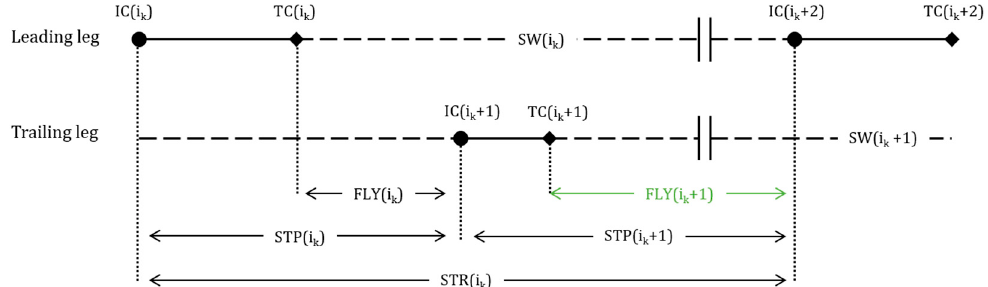
Figure 5. A sequence of temporal events for the leading and trailing leg. IC events are shown with circles, TC events with diamonds. HC events are shown with two parallel vertical bars, ground contact with a solid horizontal line, and SW with a horizontal dashed line. In green, the flight phase within which HC detected from MAG, TEMP, and ORIENT method would be classified as correctly detected.